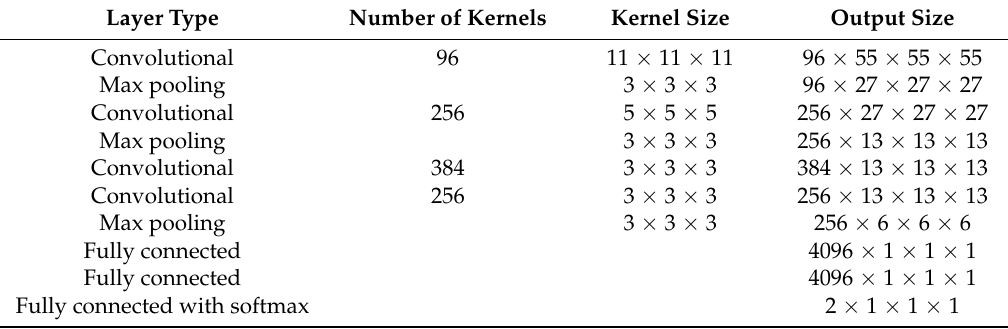
Table 2. Summary of AlexNet architecture in the classification of lung CT scan images.